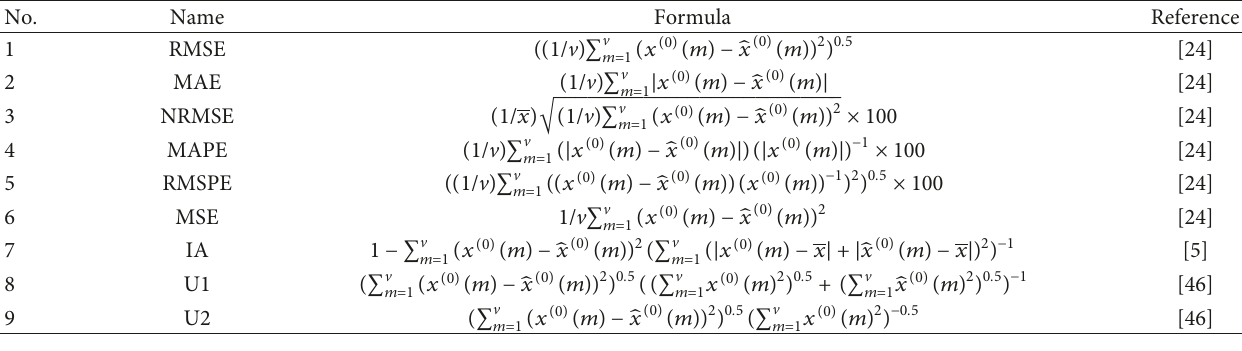
Table 2: The definition of performance metrics used.